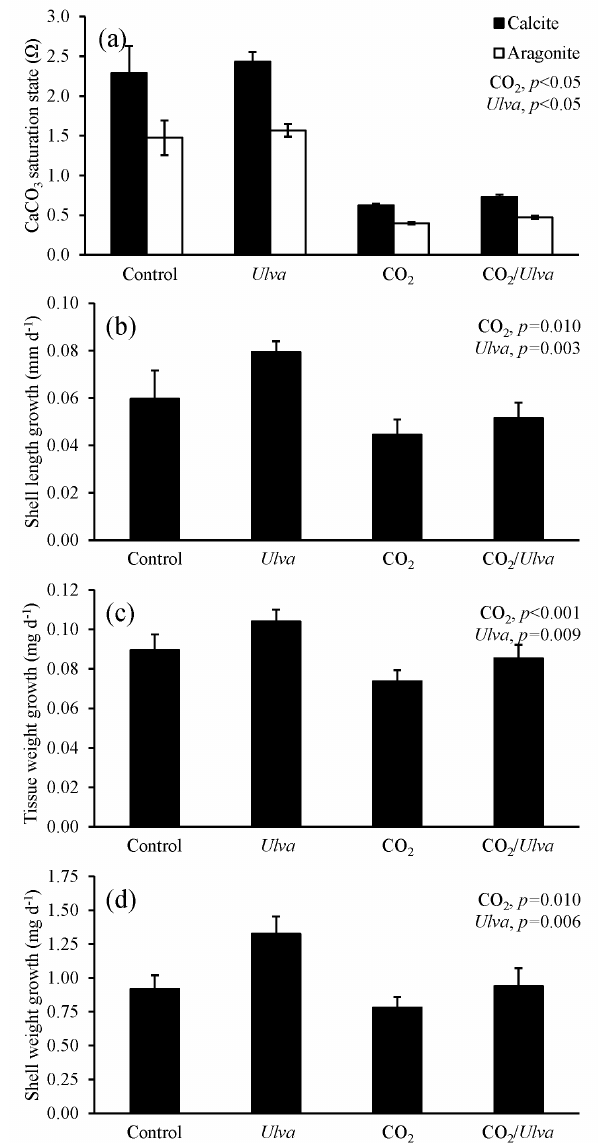
Figure 2. Experiment with large juvenile Mercenaria mercenaria exposed to ambient and elevated concentrations of CO 2 with and without the presence of Ulva . (a) (cid:127) calcite and (cid:127) aragonite ; growth was based on (b) shell length, (c) tissue weight, and (d) shell weight. Columns represent means ± standard deviation. Significant main treatment effects (CO 2 and Ulva ) appear at the top right of each